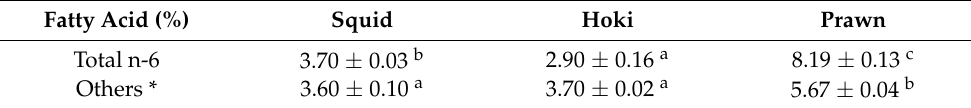
Table 1. Cont. Fatty Acid (%) Squid Hoki Prawn Total n-6 Others * Values are mean ± SD for duplicate replications. Mean values in the same row not sharing a common superscript are significantly different ( p < 0.05). SFA, saturated fatty acids; MUFA, monounsaturated fatty acids; PUFA, polyunsaturated fatty acids; OA, oleic acid; ALA, α -linoleic acid; EPA, eicosapentaenoic acid; DPA, docosapen- taenoic acid; DHA, docosahexaenoic acid; LA, linolenic acid; AA, arachidonic acid. * Others—sum of unknown fatty acid